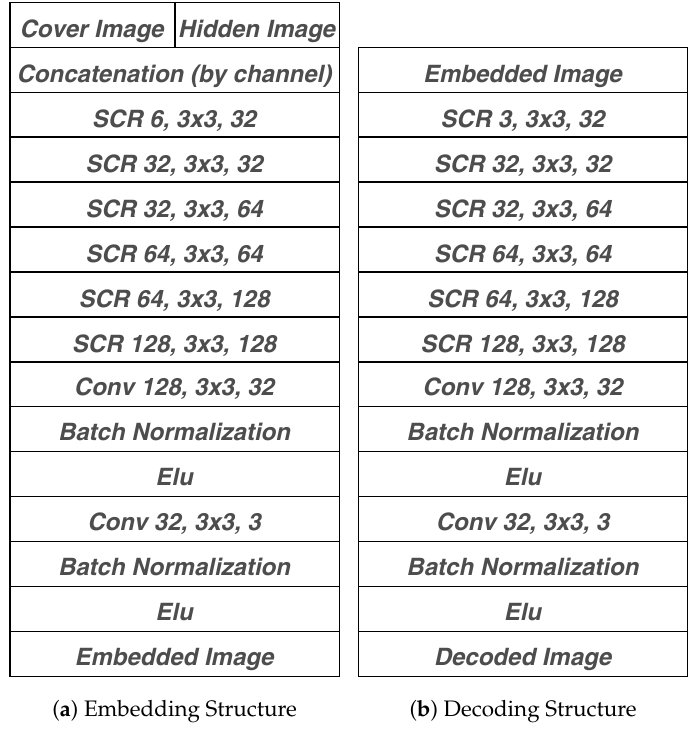
Figure 9. StegNet Network Architecture.